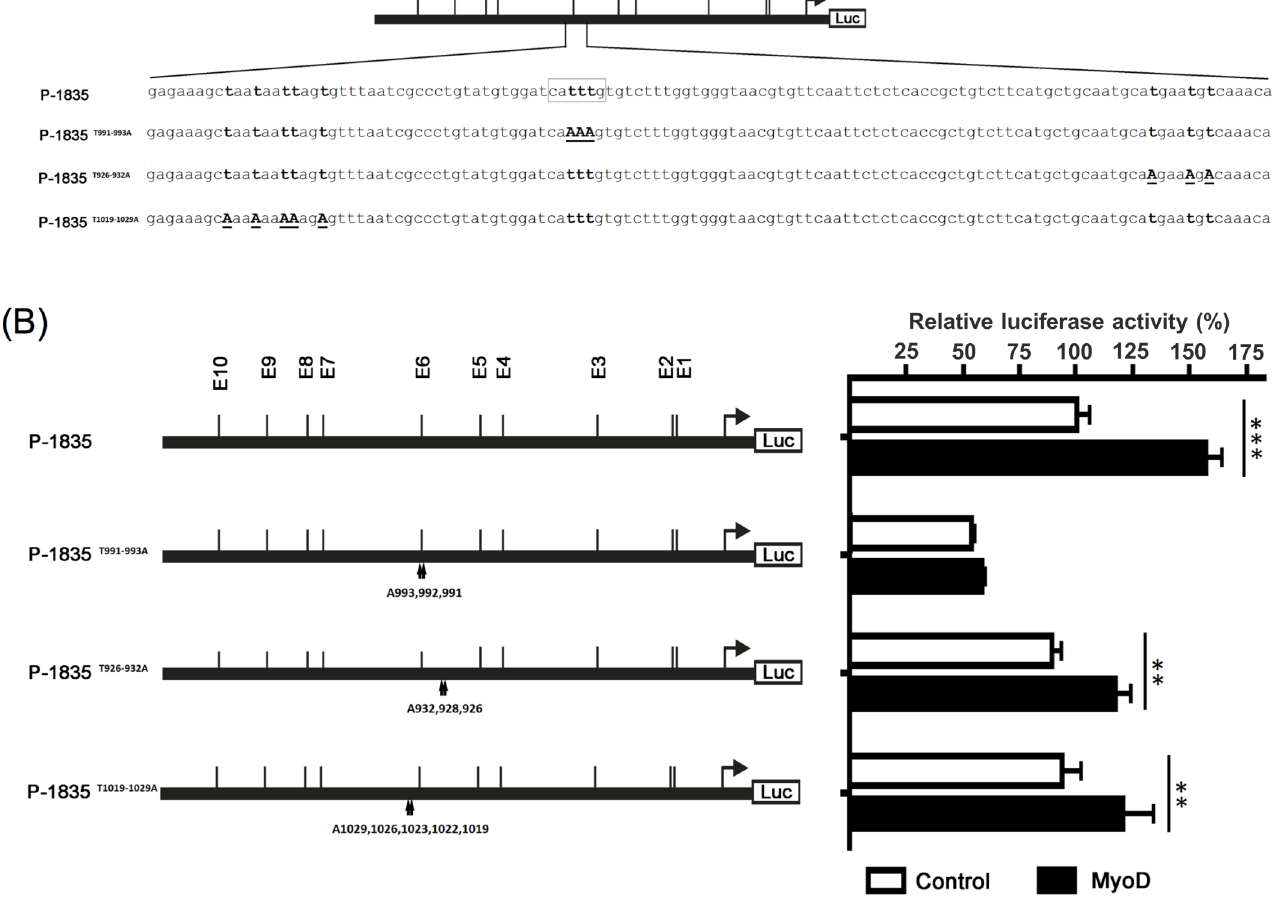
Fig 4. Characterization of the MyoD binding site. (A) The mutation site of E-box E6 (P-1835 T991-993A ), CdxA (P-1835 T926-932A ) and HNF-3b (P- 1835 T1019-1029A ) elementswere constructed by PCR-directed mutagenesis. The boxed regionindicatedthe putative E-box E6 and the mutated nucleotides presented in underlinedand in capitalletters. (B) The promoteractivity of E-box E6 (P-1835 T991-993A ), CdxA (P-1835 T926-932A ) and HNF- 3b (P-1835 T1019-1029A ) mutated constructs were analyzed.Bars indicate averages ± standarddeviations for three replicatesand asterisks show significantdifferences ( ** p < 0.01, *** p < 0.001).